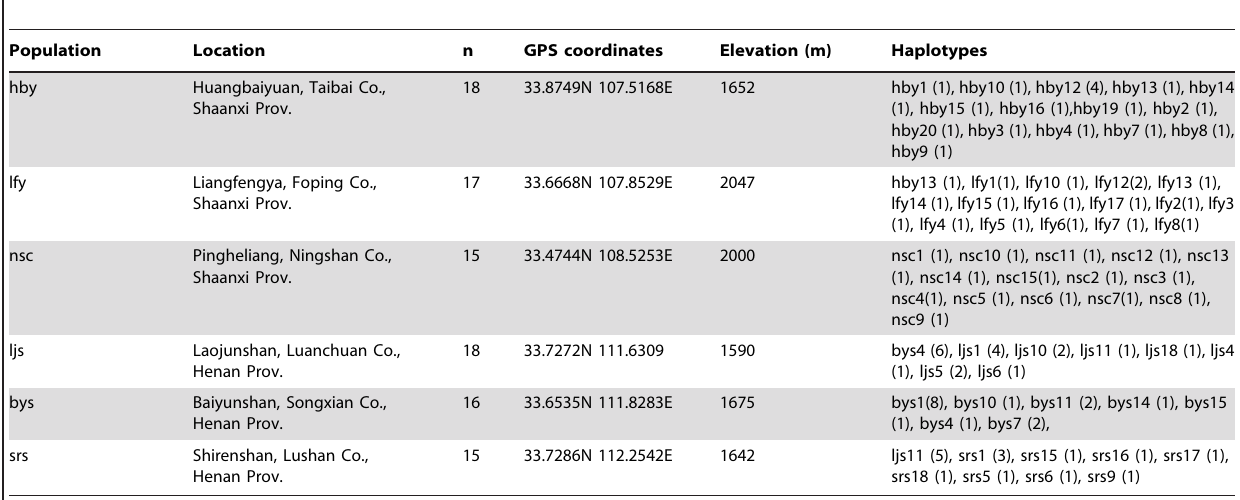
Table 1. Sampling information and haplotypes based on cyt b and COI for 6 sampled populations of Scutiger ningshanensis .